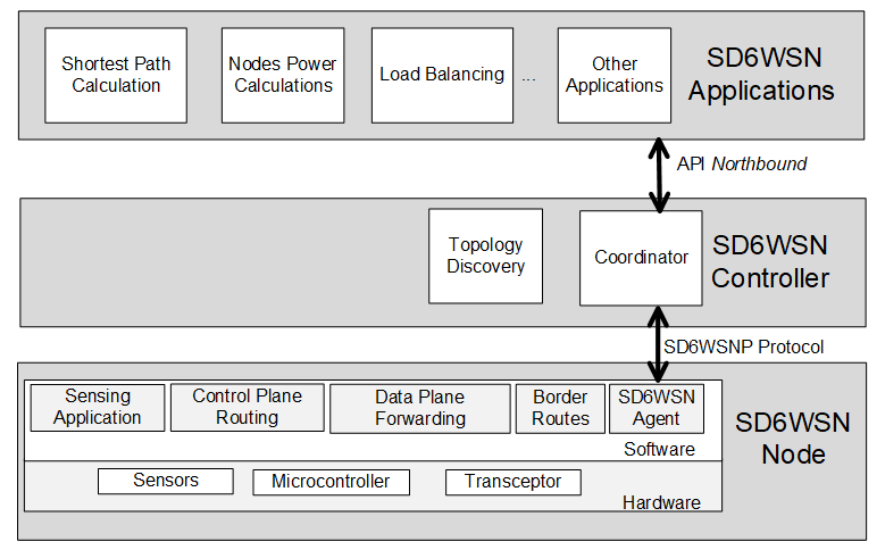
Figure 1. Software-defined 6LoWPAN wireless sensor network (SD6WSN) architecture.